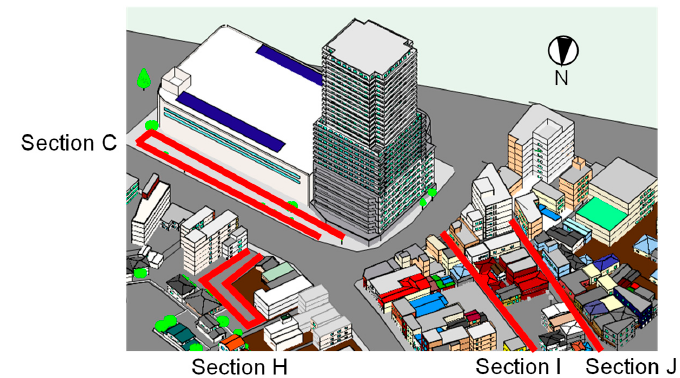
Figure 7. Shadow time diagram of the high-rise building for winter solstice.